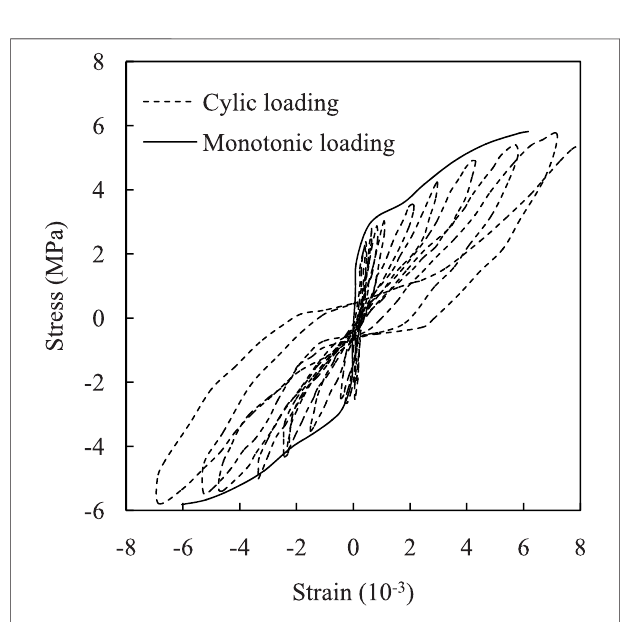
FIGURE 5 | Pinched hysteresis loops of FRCC under cyclic loading (Carnovale and Vecchio, 2014).